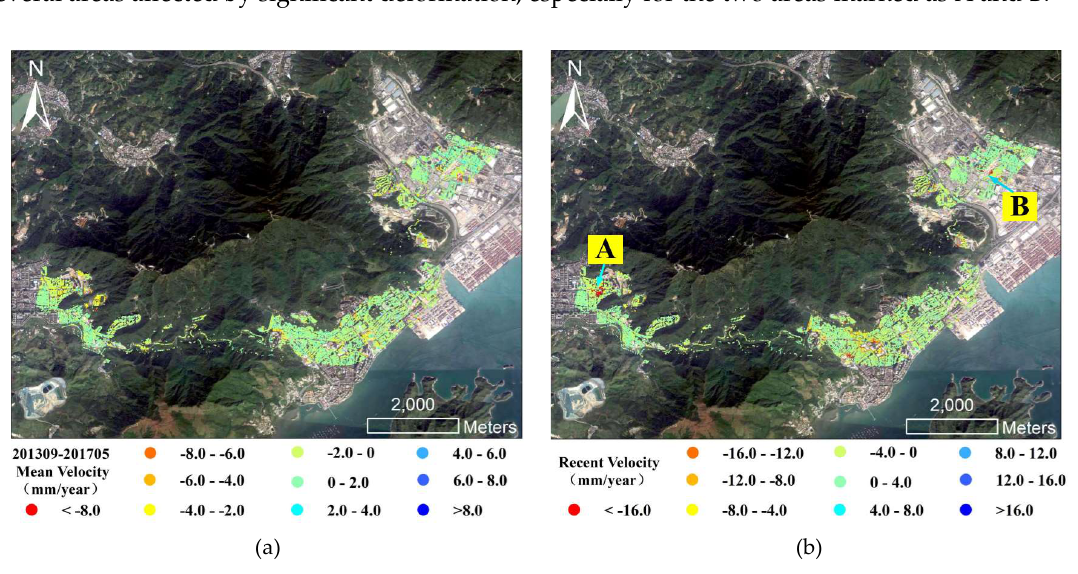
10 of 22 Figure 8. Example of temporal analysis on simulated data: Original measured deformation ( a ); retrieved periodic component ( b ), piecewise linear component ( c ), and random noise ( d ). For each PS or convergence point, the piecewise linear component decomposition provides the mean velocity of the deformation for each temporal interval and it can be used to detect a potentially critical situation in the temporal dimension. To analyze structure stability in the temporal dimension,